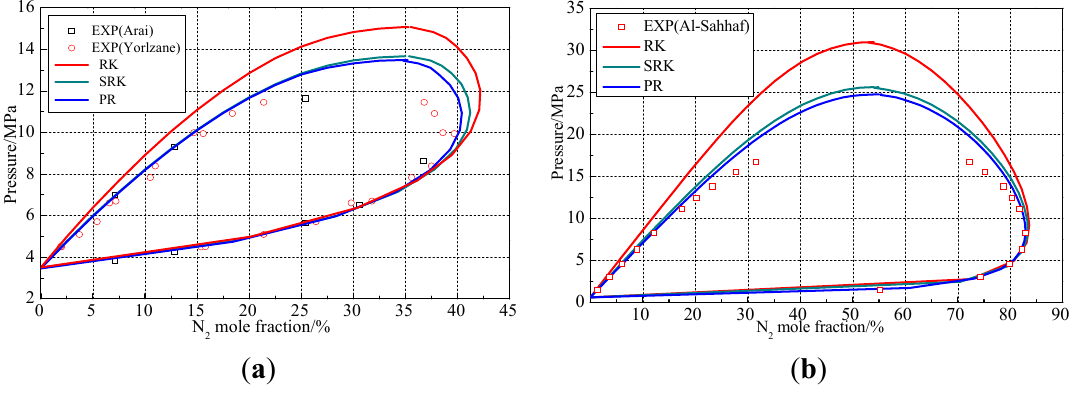
Figure 2. Comparison of p - x curves diagram of N 2 -CO 2 system at different temperatures: ( a ) 273.2 K; and ( b ) 220 K.